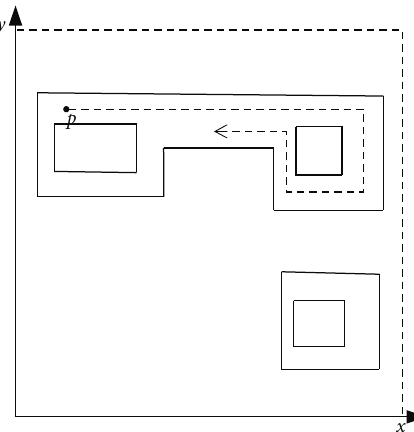
Figure 8: Random driving experiment noise.